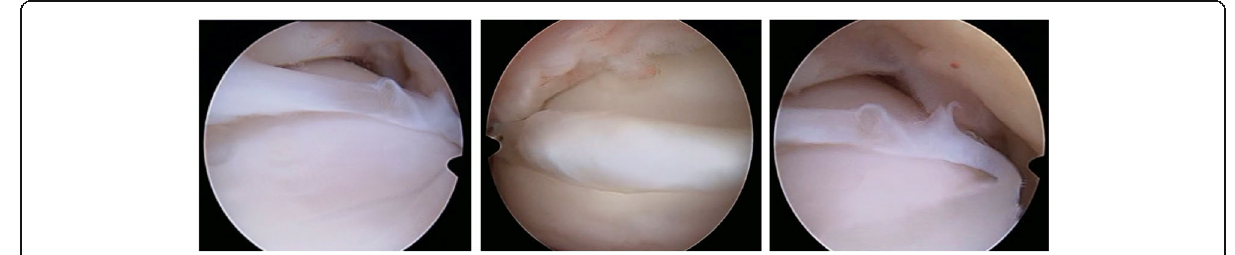
terior talofibular ligament (ATFL) in 2 ankles (MRI),